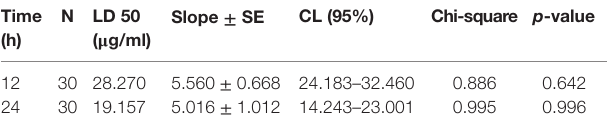
TaBle 1 | Probit analysis of Agave angustifolia larvicidal activity against Aedes aegypti larvae.